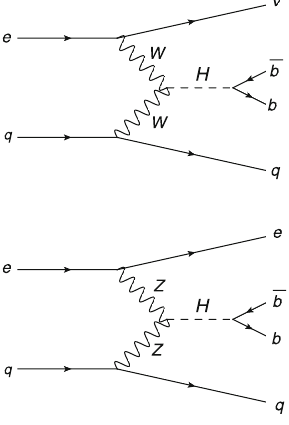
Fig. 1 Leading order Feynman diagrams for the production of Higgs bosons at the LHeC